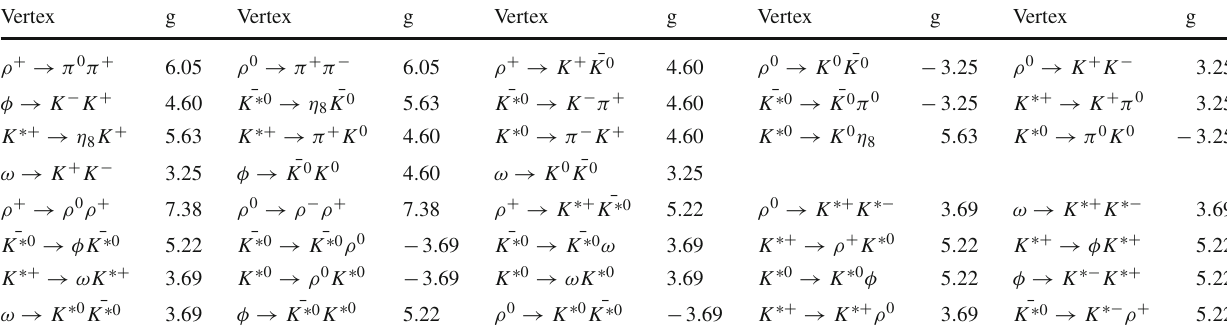
Table 6 Strong coupling constants of VPP and VVV